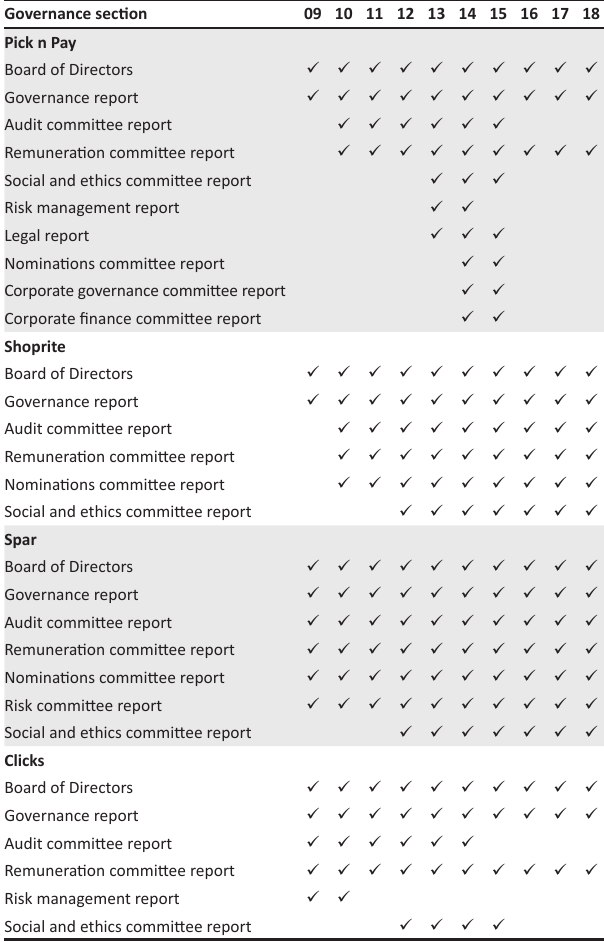
TABLE 5: Governance reports: Pick n Pay, Shoprite, Spar and Clicks. Governance